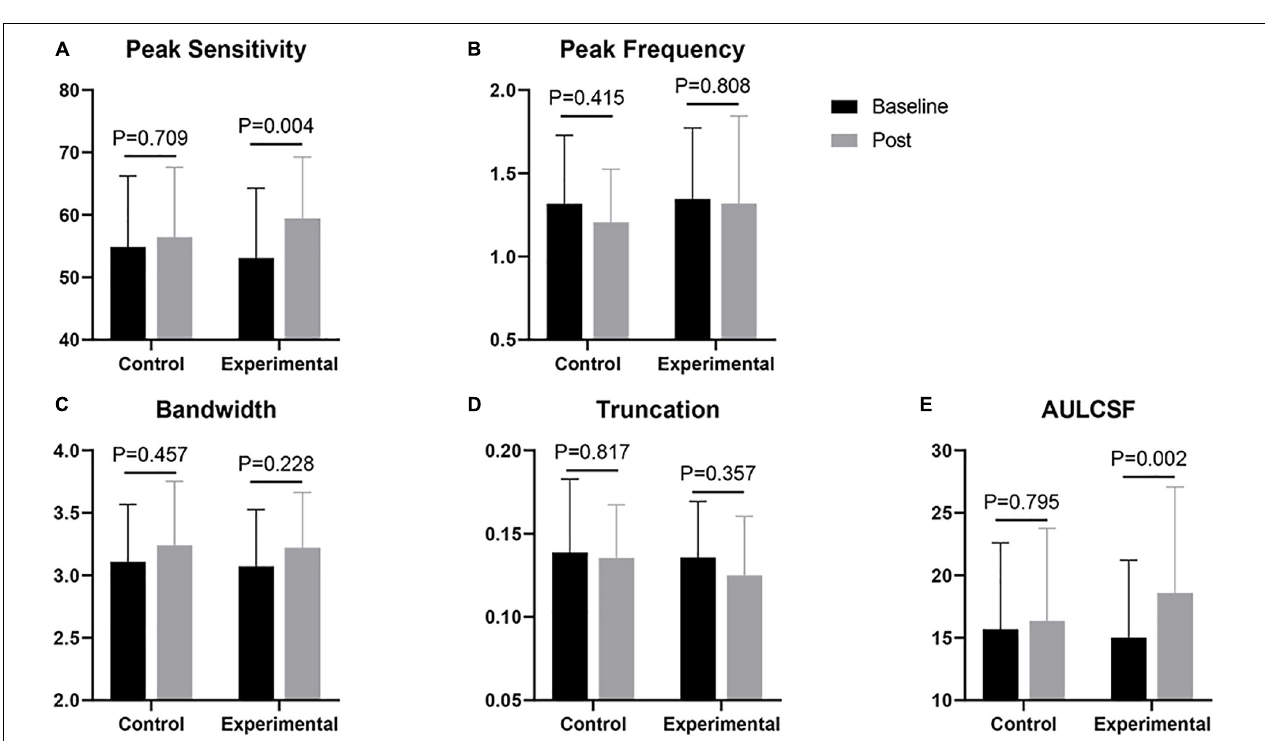
FIGURE 3 | The CSF curves in the control and experimental groups with average CSF and standard deviation value. (A) Control group. (B) Experimental group. Cpd, cycle per degree.